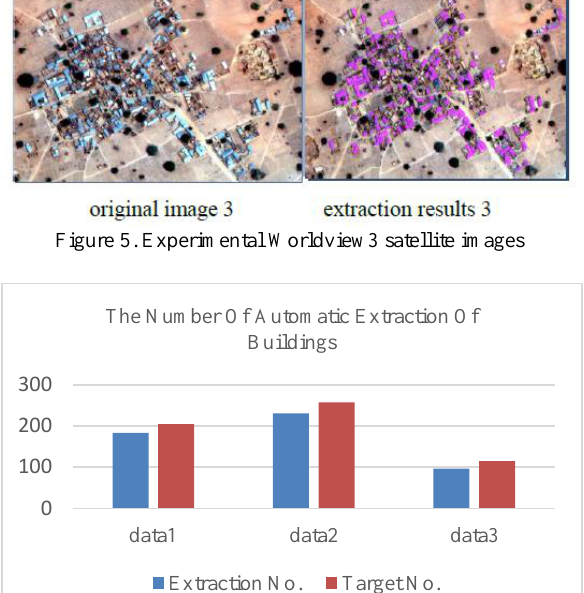
Figure 6. Chart of statistics of automatic extraction of buildings From the experimental results indicated in Figure 6, the recognition rate of the three experimental data groups was 89.7%, 89.5% and 84.3% respectively. The overall recognition rate was over 87%, which basically reached the level of artificial interpretation recognition. The main reason for the missing recognition of buildings is that the area is too small or blocked by other buildings. Also, it reflects that the noise is quite small and the ability of resistance to noise of the training sample is